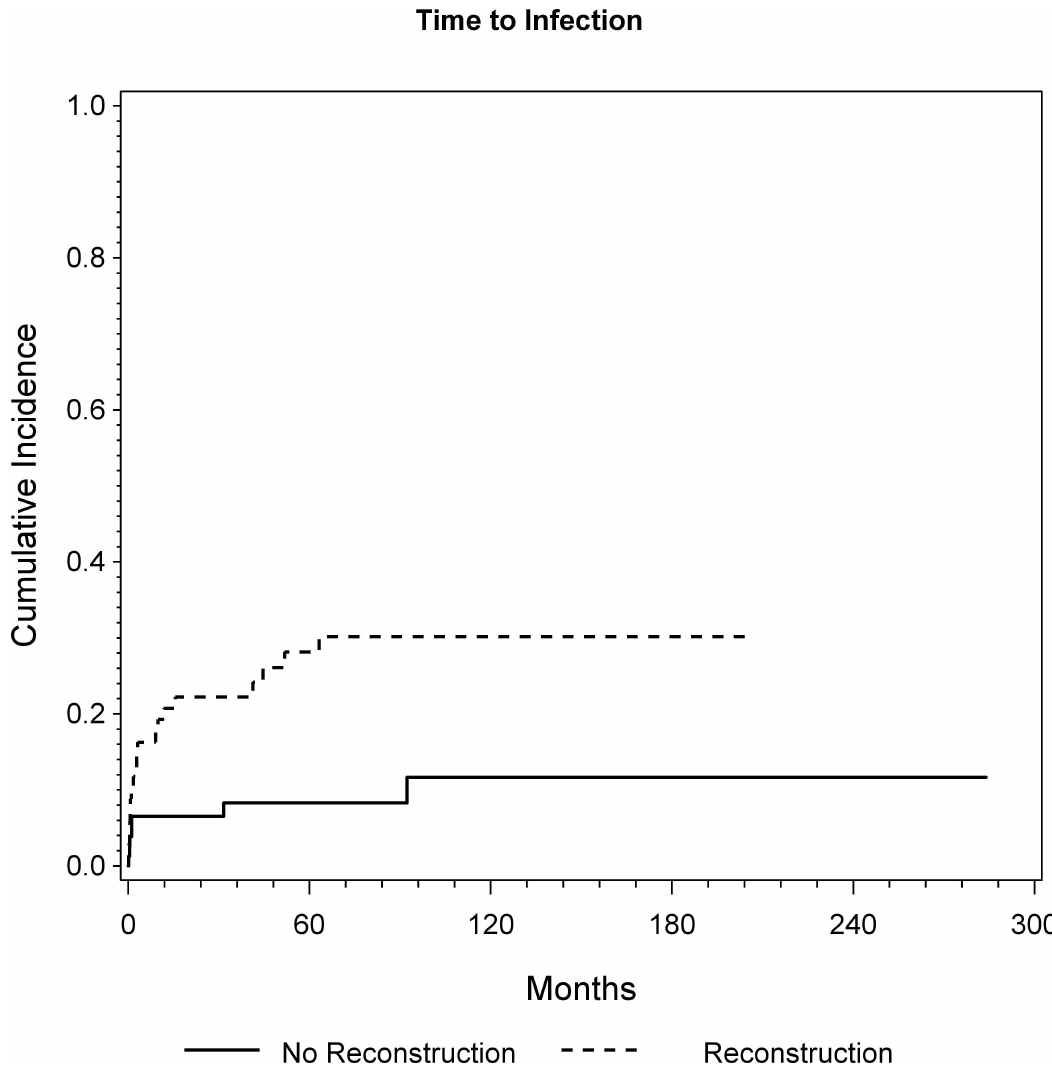
Fig 5. Cumulative incidence of infection for patients with and without endoprosthetic reconstruction was assessedby CR analysis (p = 0.0017; HR = 4.11).